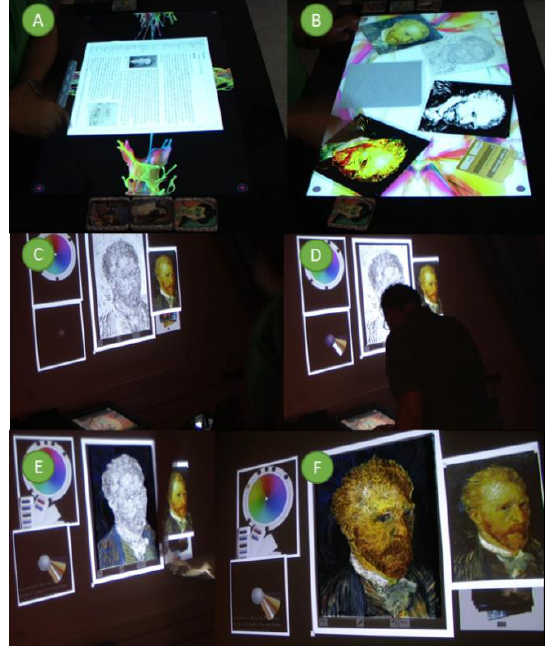
Figure 4. Intermediate steps for the reproduction of a self-portrait by Vincent Van